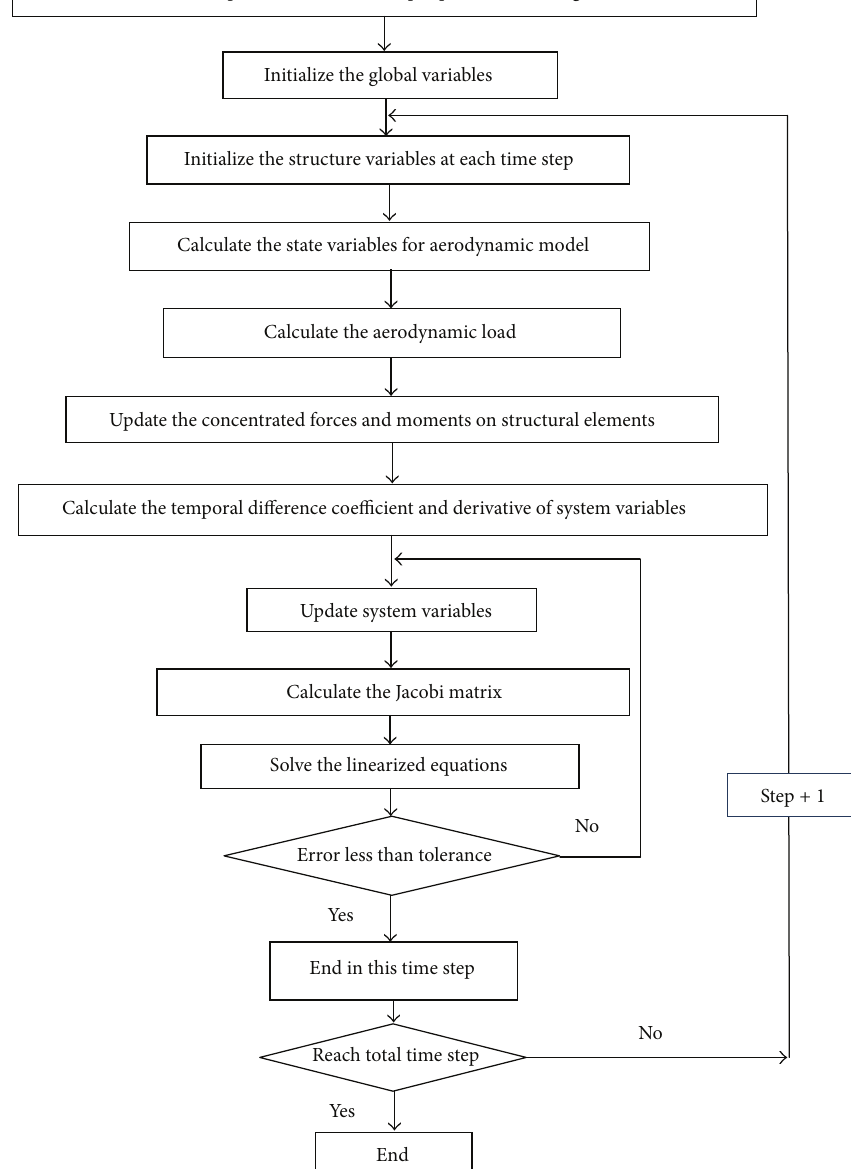
Figure 4: Flowchart of dynamic load analysis for helicopter rotors.